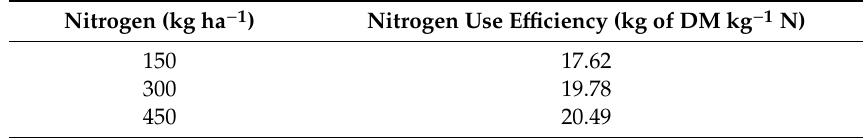
Table 5. Nitrogen use e ffi ciency by Brachiaria brizantha cv. Piat ã under rotational stocking and nitrogen fertilization throughout seasons of the